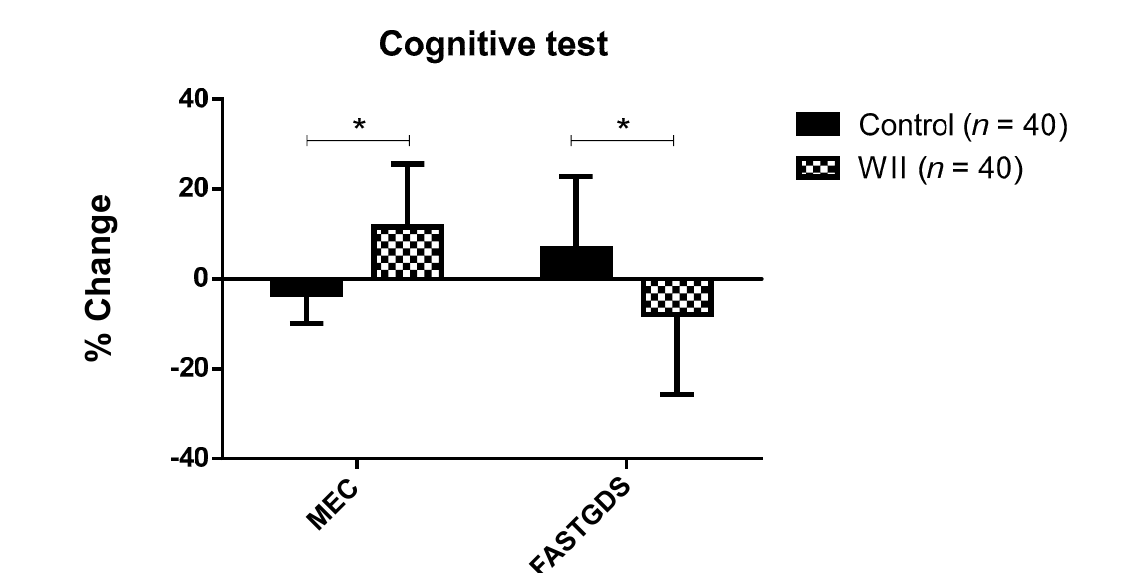
Figure 2. Change percentage during the study in both groups on cognitive variables; data are expressed as the mean ± standard deviation (SD); * Significant differences between groups ( p < 0.001). Table 4. Psychological data of the control group and Wii group before and after the